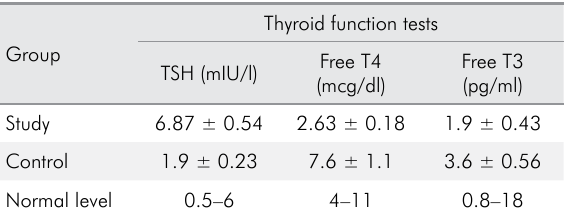
Table 1. Mean level (±SD) of thyroid gland function tests in study and control groups.